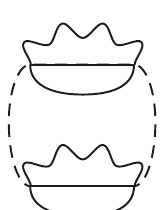
Figure 2. This is the leading diagram that contributes to interactions between replicas. In the (cid:12)gure the top three lines would be associated with a di(cid:11)erent replica index than the other three below. One can check that this (cid:12)gure is proportional to 1 =N